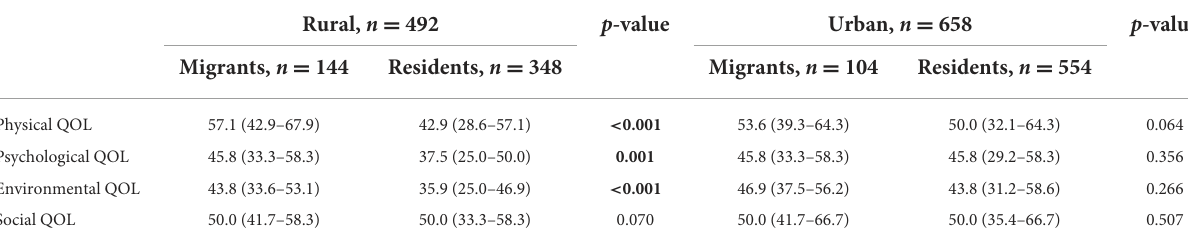
TABLE 2 Quality of life scores among urban and rural adults with rare diseases by migration status.